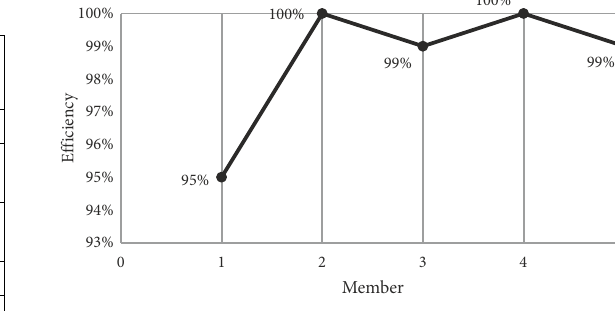
Figure 14. The efficiency of each member in all intervals Table 12. The estimated members’ idle times in each interval